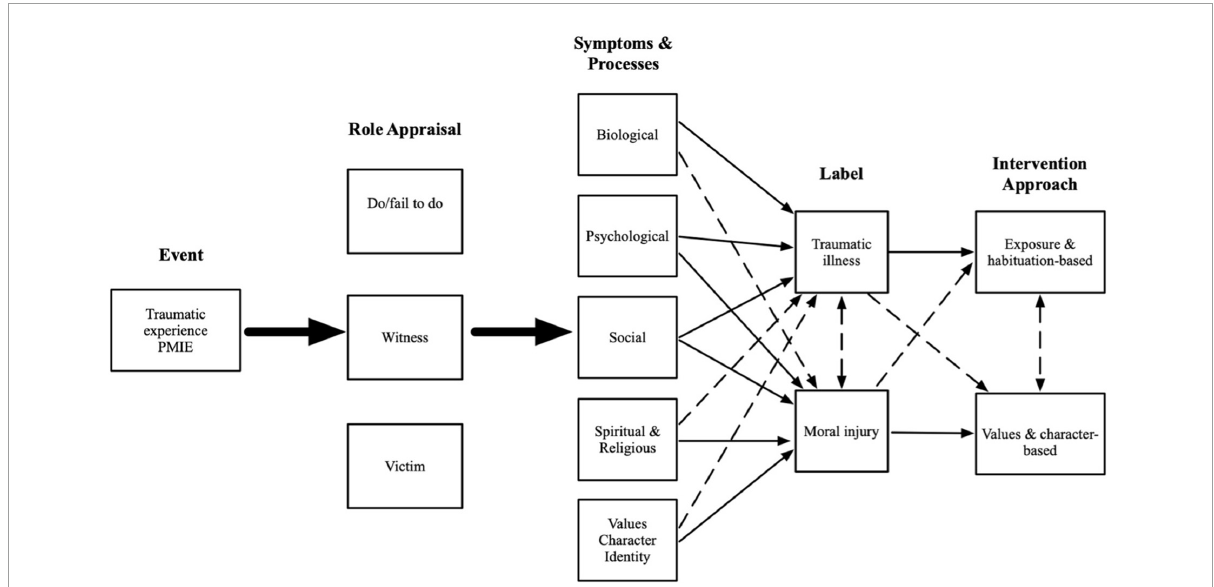
FIGURE1 Conceptual diagram of the dual process model of moral injury and traumatic injury. The two large solid arrows indicate that events can lead to any and all role appraisal, and that any and all role appraisals can lead to any and all symptoms and processes. Thin solid arrows indicate a primary/strong link between individual symptoms and processes and labels and intervention approaches. Thin dashed arrows indicate a secondary/weak link between individual symptoms and processes and labels and intervention